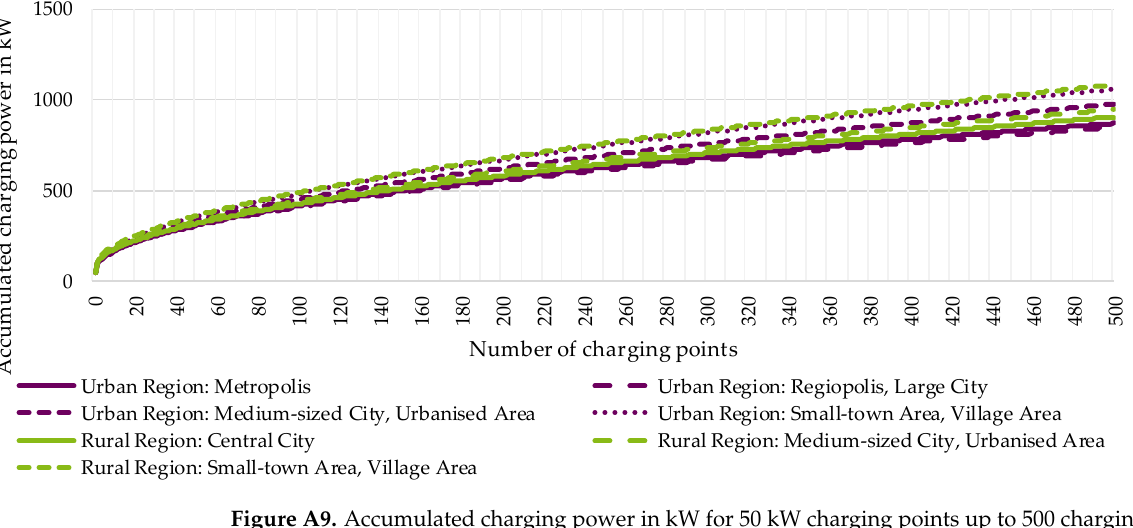
Figure A10. Accumulated charging power in kW for 22 kW charging points up to 500 charging points for seven area types.